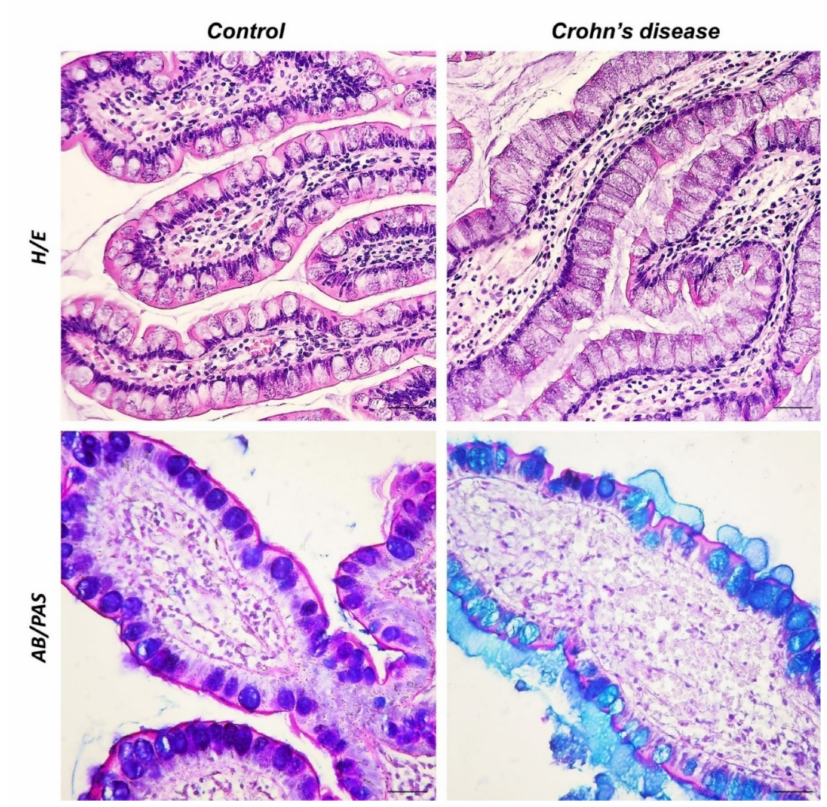
Figure 1. H/E and AB/PAS staining. 40 × , scale bar: 40 µ m. In the control samples, the intestinal ep- ithelium appeared regular with columnar cells along the villi covering the luminal surface, consisting mainly of enterocytes, and goblet cells with rounded calyxes. The altered epithelial architecture was observed in the CD sections. Rarefied enterocytes were present among goblet cells with an elongated calyx. Infiltration of inflammatory cells, collagen deposition, and accumulation of mesenchymal cells were observed in the lamina propria of CD samples. The control samples stained with AB/PAS showed purple goblet cells, while in the CD samples, the goblet cells were highlighted in blue, with an evident layer of acidophilic